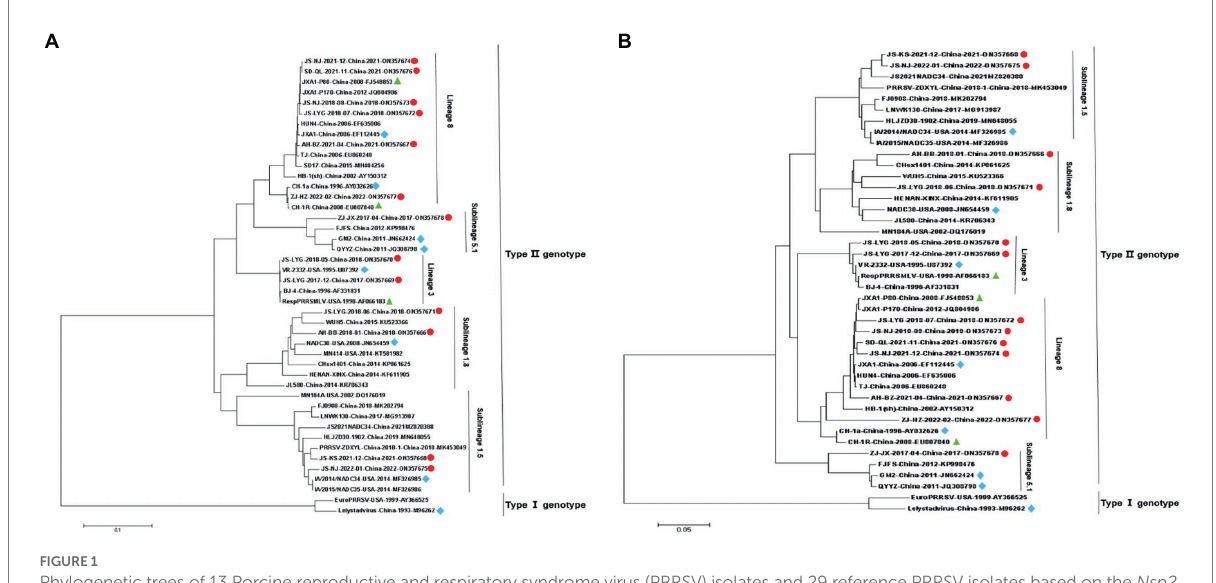
FIGURE 1 Phylogenetic trees of 13 Porcine reproductive and respiratory syndrome virus (PRRSV) isolates and 29 reference PRRSV isolates based on the Nsp2 and ORF5 gene sequences of these isolates. (A) Nsp2 nucleotide; (B) ORF5 nucleotide. The represent sequences of different PRRSV strains are indicated with blue diamonds. The new PRRSV isolates identified in this study are labeled with red circles and PRRSV vaccine strains are indicated with green triangles.